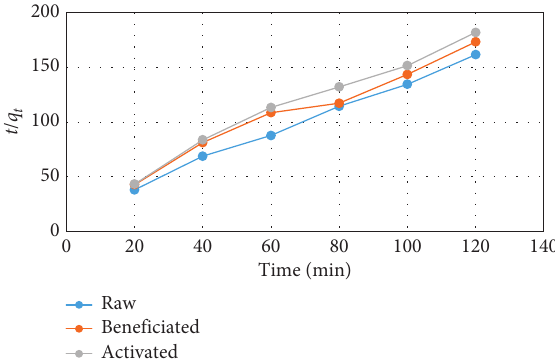
Figure 9: Pseudo-first-order kinetics model for all adsorbents at 50mL of 25mg/L of MB concentration.